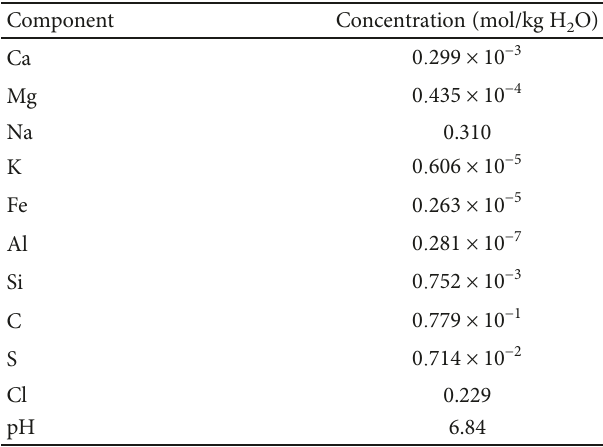
Table 4: Initial total dissolved component concentrations in the water for reactive transport